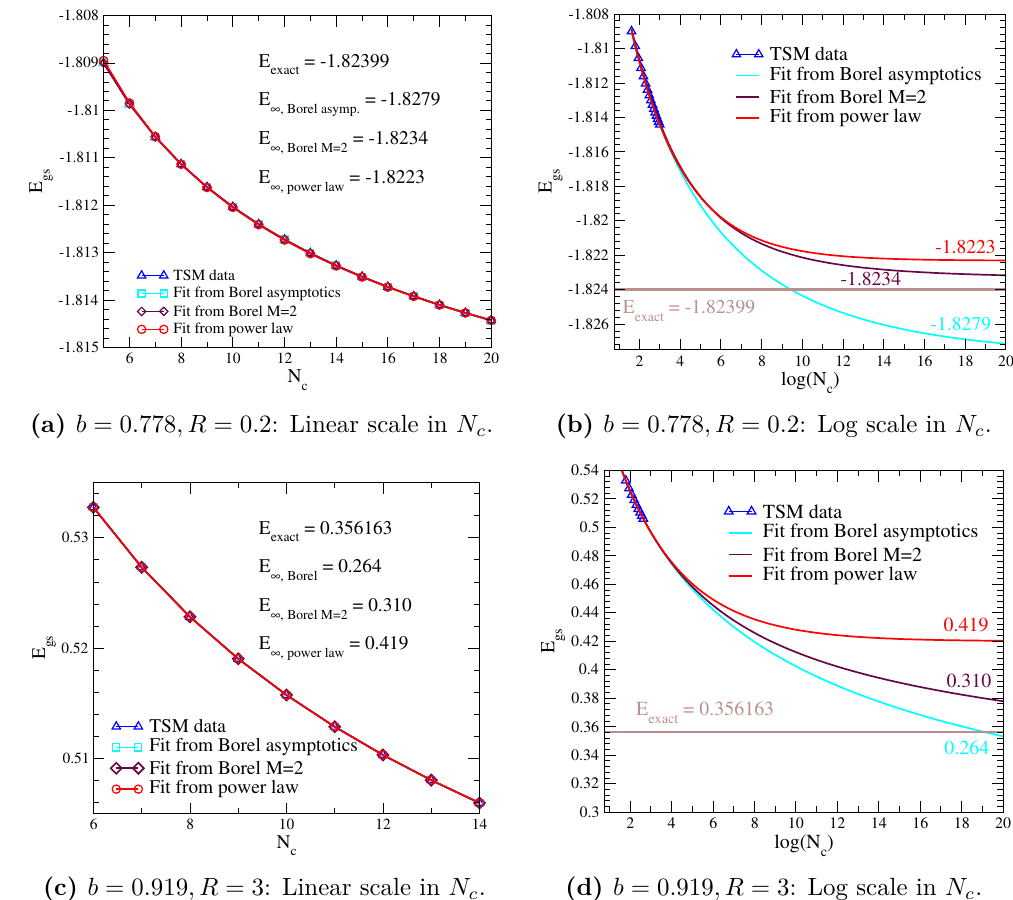
Figure 21. Top panels: Borel and power-law fits for R = 0 . 2 , b = 0 . 778 . The exponent ν given in eq. (7.21) of the power law fit is 0 . 38 . This can be compared with exponent predicted by the Borel asymptotics, ν = 0 . 13 . Bottom panels: Borel and power law fits for R = 3 , b = 0 . 919 . The exponent (eq. (7.21)) of the power law fit is ν = 0 . 215 while that expected from the Borel asymptotics is ν ≈ 0 . 014